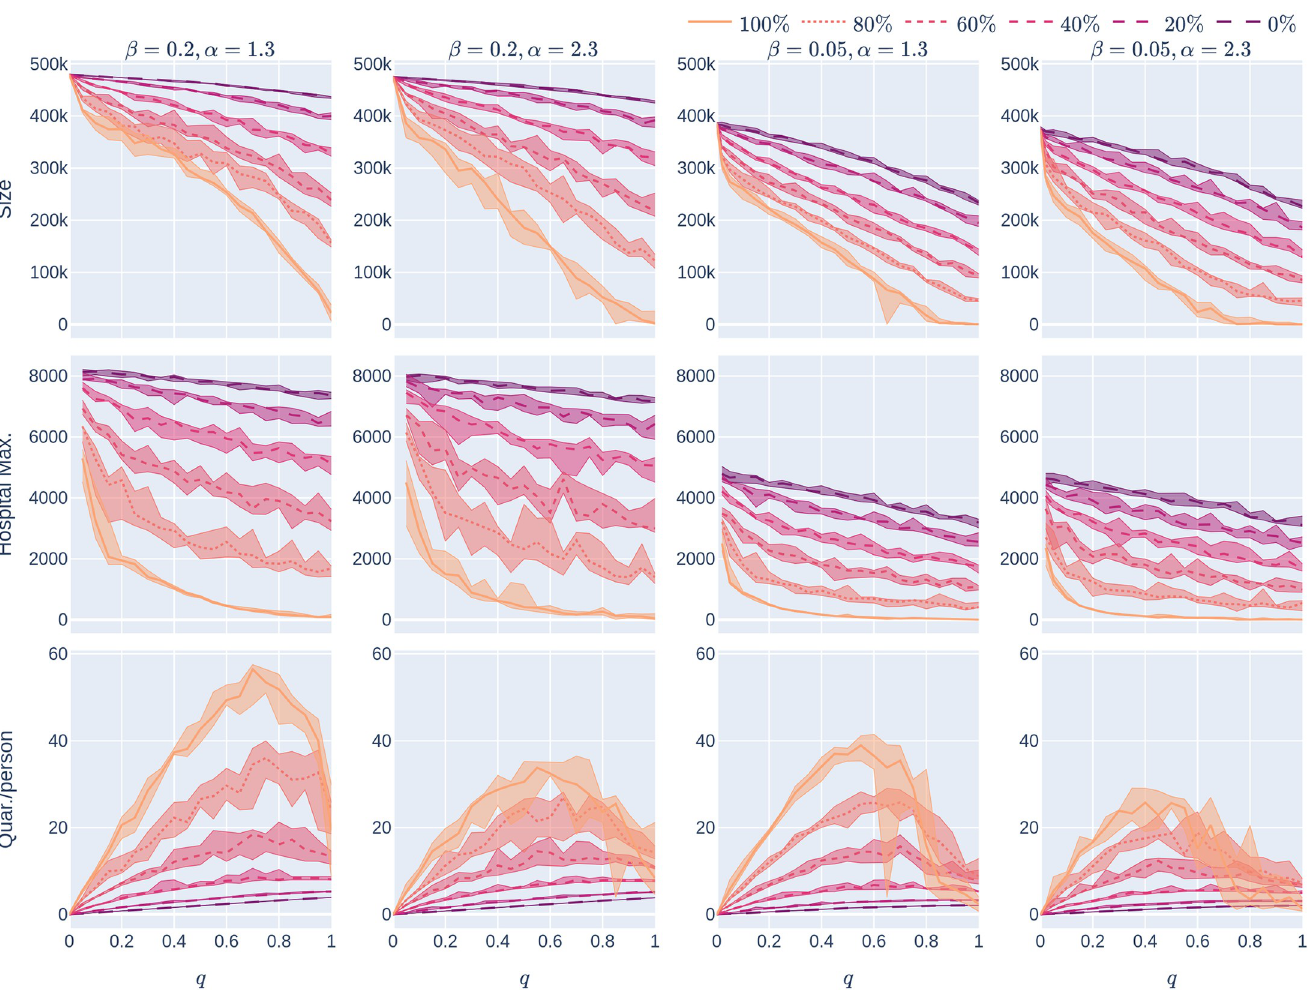
Fig 17. The effect of geometry and level of infectiousness on Experiment 2: The different curves correspond to different CTA uptake-rates ( p %), all in the random-uptake scenario in a 500,000-node GIRG with many super-spreaders ( τ = 2.3). The four columns represent different scenarios—the first column has β = 0.2 (a high infection rate, perhaps caused by less social distancing) and α = 1.3. The second column also has β = 0.2, but with a higher α , implying fewer (but not significantly fewer) long-range edges. Observe that the effect of increasing α is not very significant, corresponding to the explanation in Section 1.4.4. The final two columns represent scenarios with a lower underlying infection rate ( β = 0.05), with varying levels of geometry. The three rows correspond to the three KPIs. The x -axis shows the quarantine strictness q varying from 0 to 1 at step size 0.05. Simulations are done for the 21 values of q corresponding to these steps. There is an additional simulation point at 0.02 (in order to avoid division by 0 in the computation for HMax and still have a point close to 0). For each parameter value, the plotted result is the median over 5 runs. The shaded region around the plot covers the results of all 5 simulations. The epidemic is started by infecting 100 individuals, chosen uniformly at random. Simulation is halted when there are no more exposed or infected